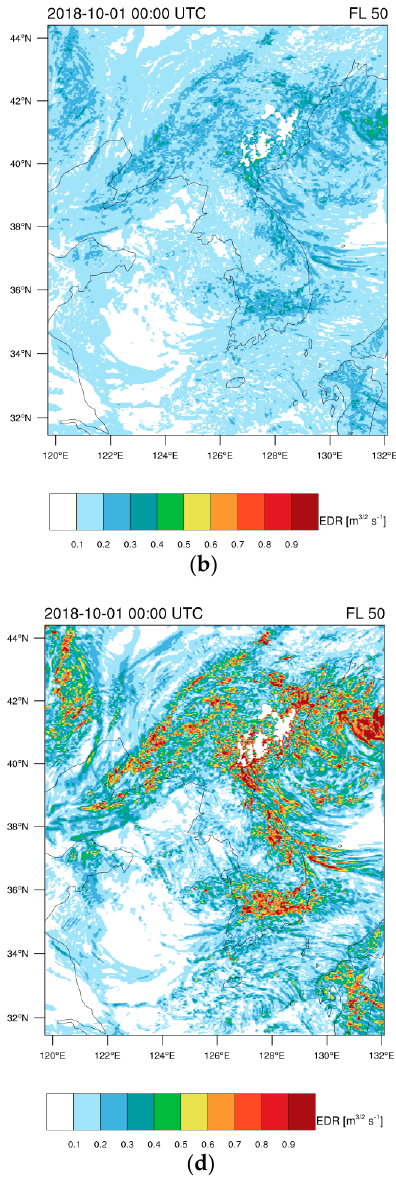
Figure 9. ( a ) PDFs of the EDR for (blue) stable and (orange) unstable planetary boundary layers (PBL), (green) PDF of the EDR regardless of the atmospheric stability, and ( b ) (red line) the best-fit lognormal curve for (black dots) the observed PDF of the EDR where the black dots correspond to the green line in ( a ). ( c ) Same as ( a ) but double rotation was applied, and ( d ) same as ( b ) but double rotation was applied. Atmospheric stability in ( a ) was classified by using the Obukhov length defined in Equation (11). Blue vertical lines in ( b ) show the thresholds of EDR values, 0.15 m 2/3 s − 1 , 0.22 m 2/3 s − 1 , and 0.33 m 2/3 s − 1 , which correspond to the light (LGT), moderate (MOD), and severe (SEV) turbulence intensities for mid-size aircraft like B-737.